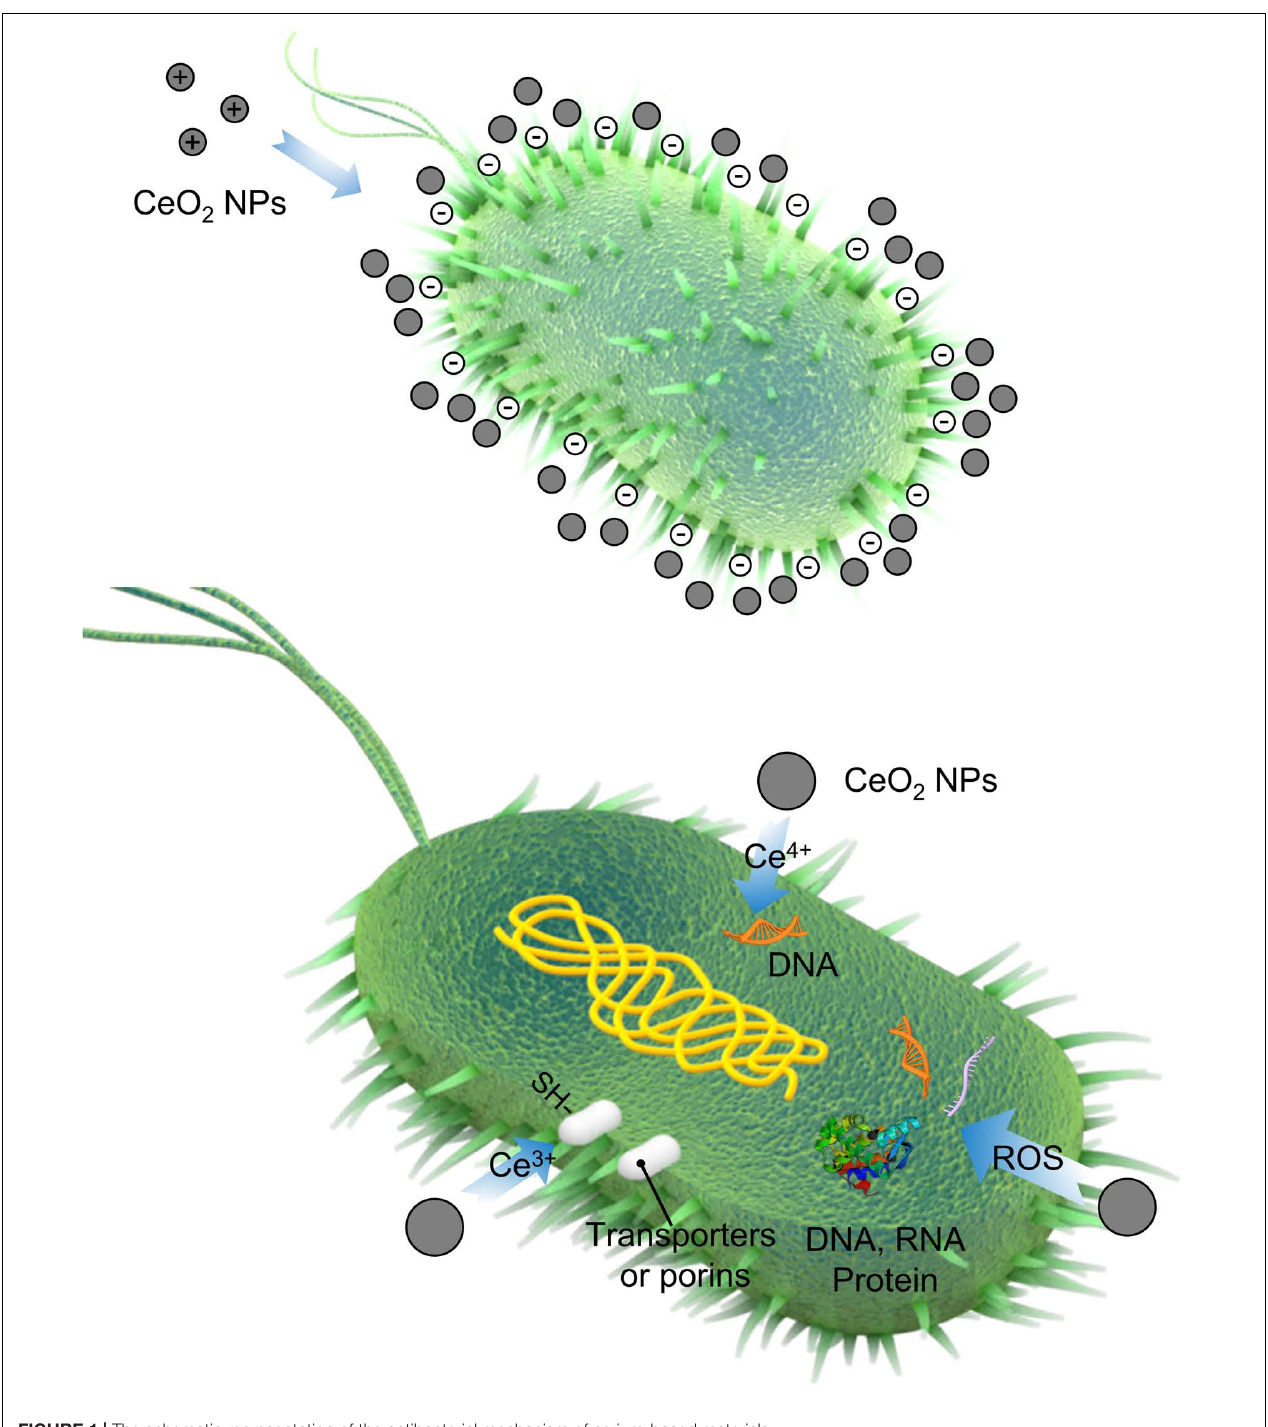
FIGURE 1 | The schematic representation of the antibacterial mechanism of cerium-based materials.